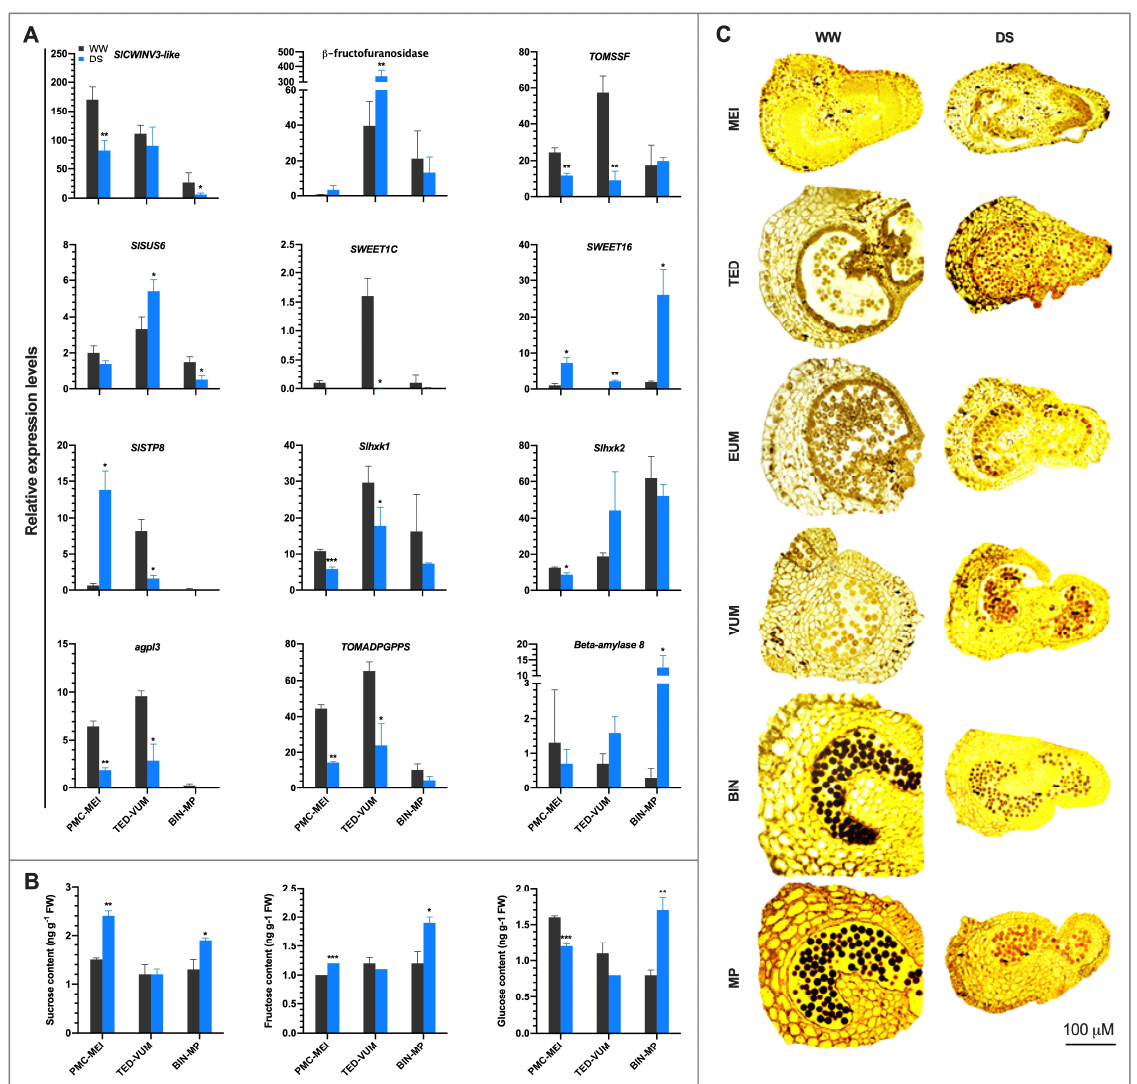
Figure 6. Comparison of sucrose and starch metabolism in three groups of anthers of different developmental stages exposed to drought stress. ( A ) Expression analysis of genes involved in sucrose and starch metabolism, and sugar transport. Gene expression levels were based on the number of fragments per kilobase of transcript sequence per millions (FPKM) base pairs sequenced from RNA-Seq data. ( B ) Sucrose, glucose, and fructose contents in anthers of DS plants. Anthers of equivalent developmental stages were sampled from WW and DS plants 4 days after drought stress. Values are means ± SD ( n = three replications, 24 plants each). * p < 0.05; ** p < 0.01; *** p < 0.001 ( t -test). ( C ) Starch accumulation in tomato anthers determined by staining with Iodine Potassium Iodide (IKI) solution. WW, well-watered anthers; DS, drought-stressed anthers; MEI, anthers at the meiotic stage; TED, anthers at tetrad stage; EUM, anthers at early uninucleate microspore stage; VUM, anthers at vacuolated uninucleate microspore stage; BIN, anthers binucleate stage; MP, anthers at mature pollen